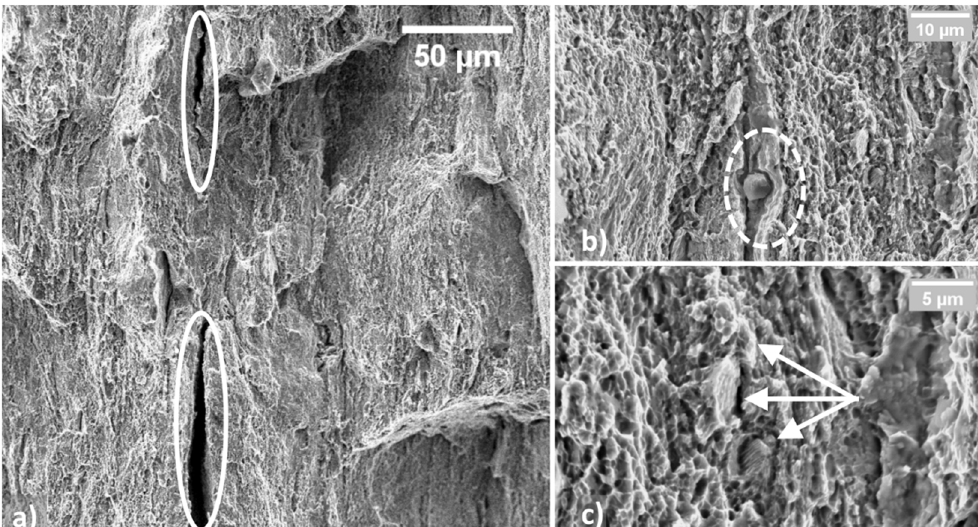
Figure 7. Fractured surface of tensile C67 sample; large areas appear as delaminated ( a ); secondary phases, such as pro-euctectoidic carbides were found ( b ); far away from delaminated areas, the fracture is ductile, and perlite grains are still visible ( c ).